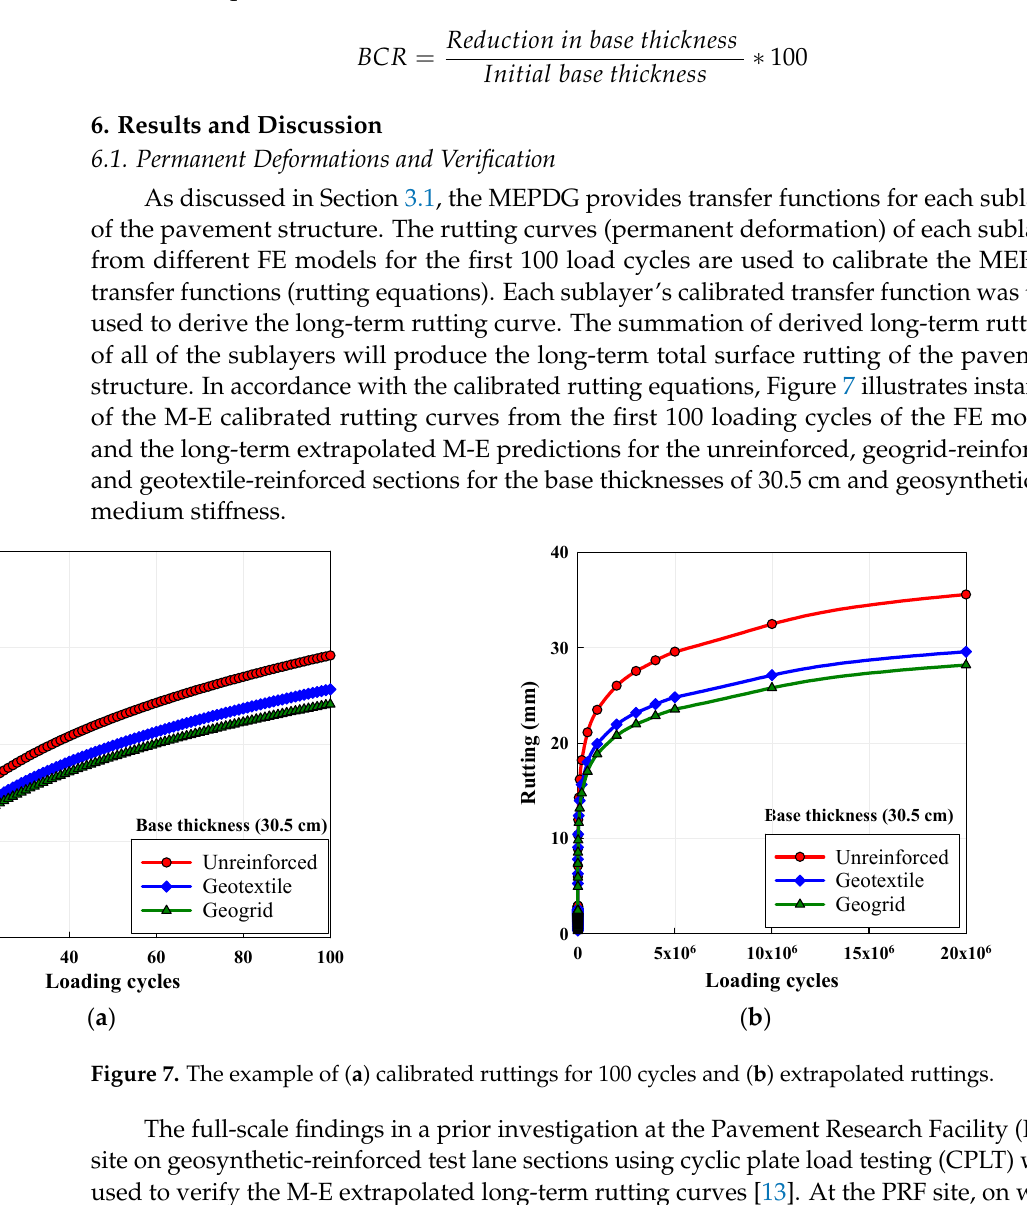
site, on weak subgrade soil (CBR = 1.5), six test lane sections with a length of 24.4 m and